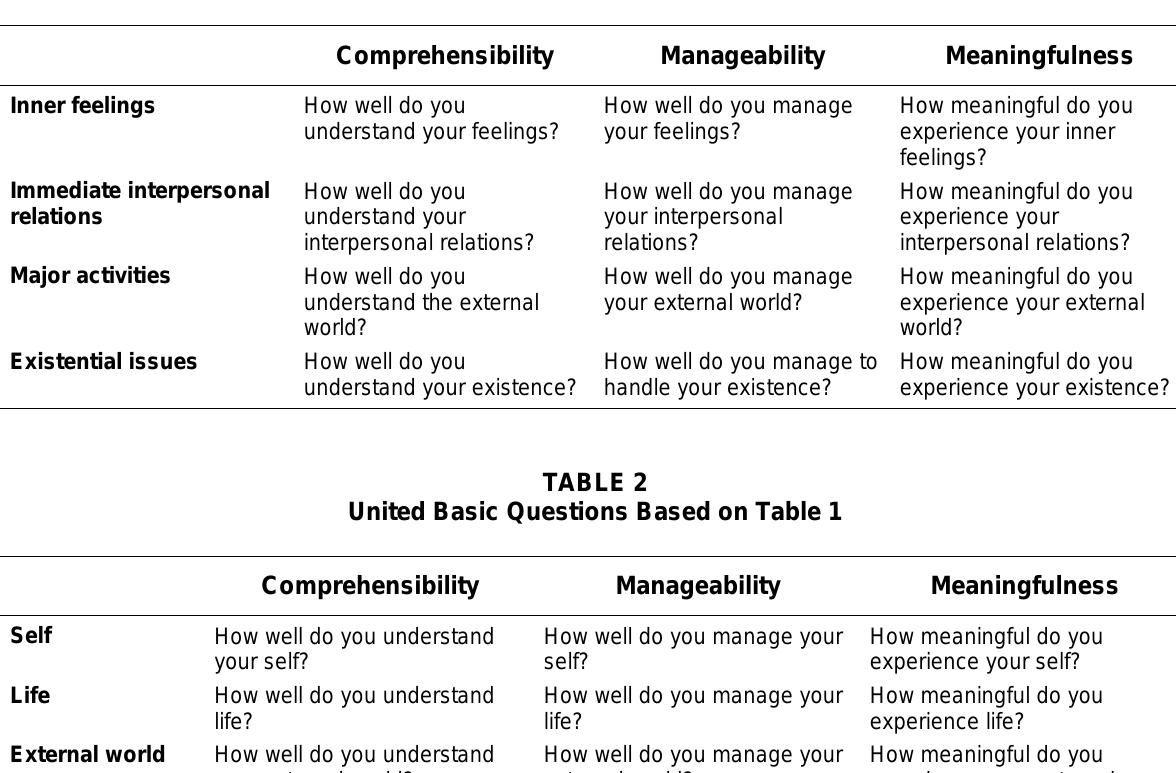
Basic Questions Constructed on the Basis of Antonovsky’s Theory